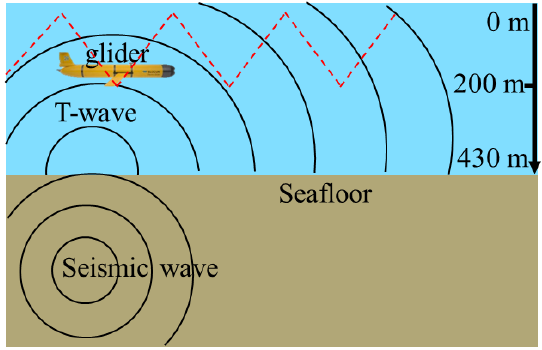
Figure 11. The creation of T-waves from seismic waves and detection by the underwater glider.